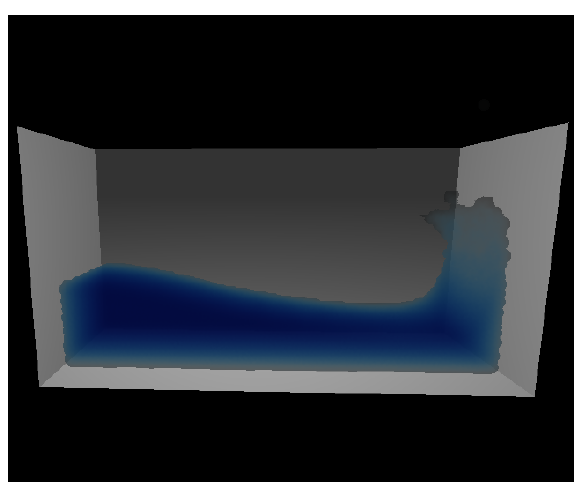
Fig. 18: Simulation state at 0 . 43 s